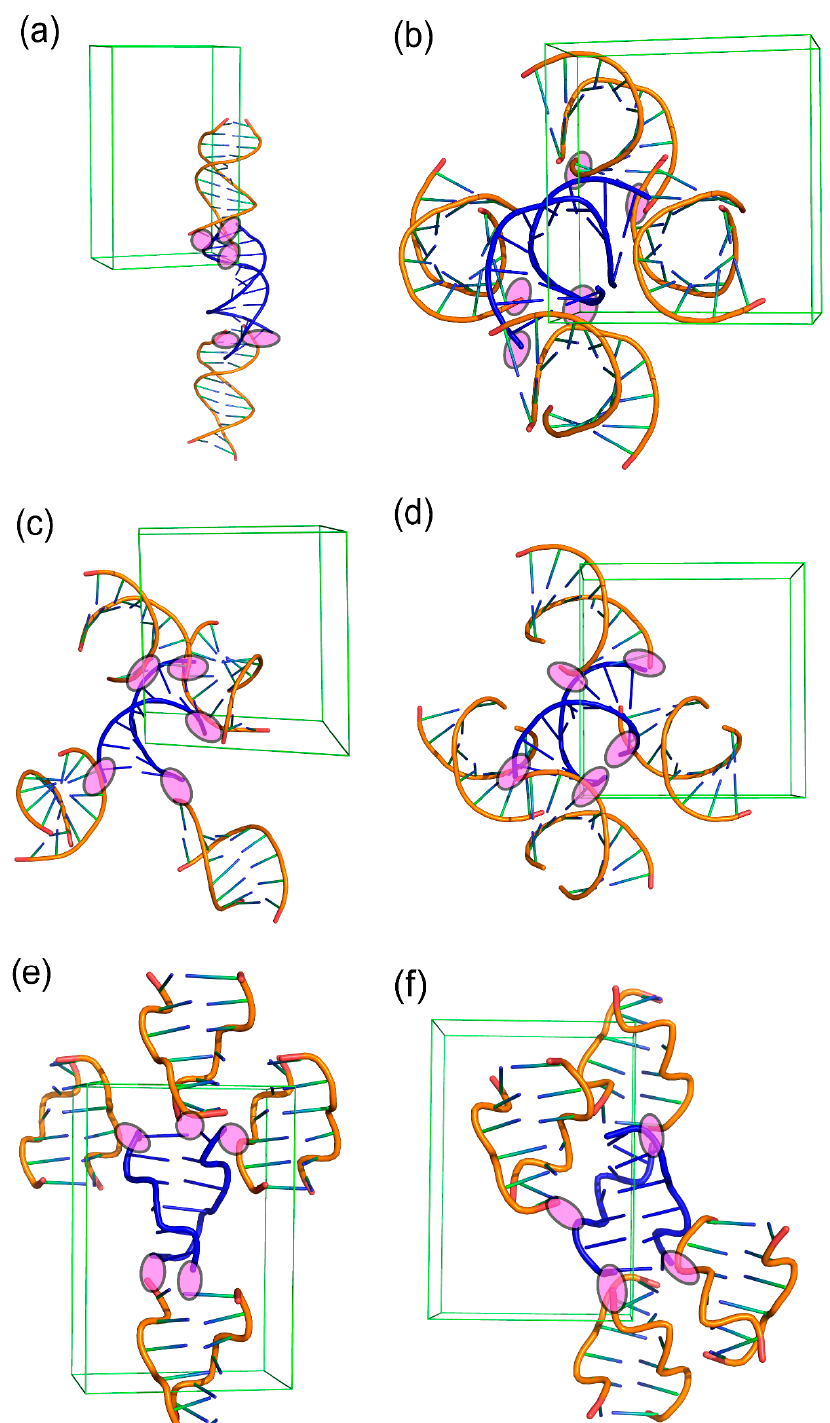
Figure 4. The packing interactions found in various symmetry, packing type, and conformation. RepresentativeDNAstructuresbelongingtothegroupswithfollowingcombinations, conformation-packing type-space group, are used for presenting structures and intermolecular H-bond interaction in each group, a unit cell is also shown. ( a ) B-DNA-Type 3- P2 1 2 1 2 1 (PDB ID 388D), ( b ) A-DNA-Type 2- P2 1 2 1 2 1 (PDB ID 321D), ( c ) A-DNA-Type 2-P6 1 (PDB ID 1D91), ( d ) A-DNA-Type 3- P2 1 2 1 2 1 (PDB ID 371D), ( e ) Z-DNA-Type 2- P2 1 2 1 2 1 (PDB ID 133D), and ( f ) Z-DNA-Type 3- P2 1 2 1 2 1 (PDB ID 6BST). The representative structure in each group is shown in blue and its symmetry equivalent molecules in coral. The intermolecular H-bonds are shown as magenta filled